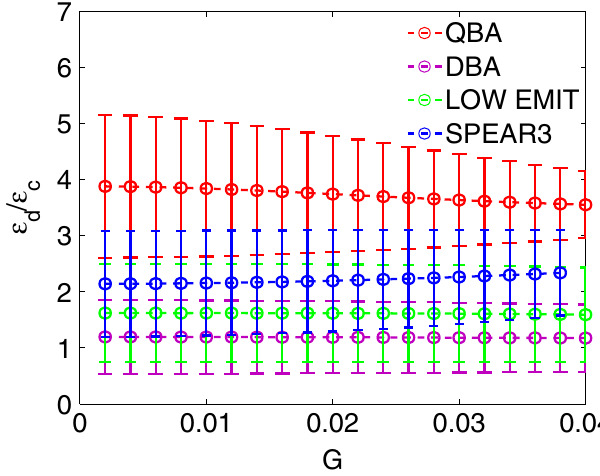
=(cid:7) for a 24-cell QBA-lattice, d c